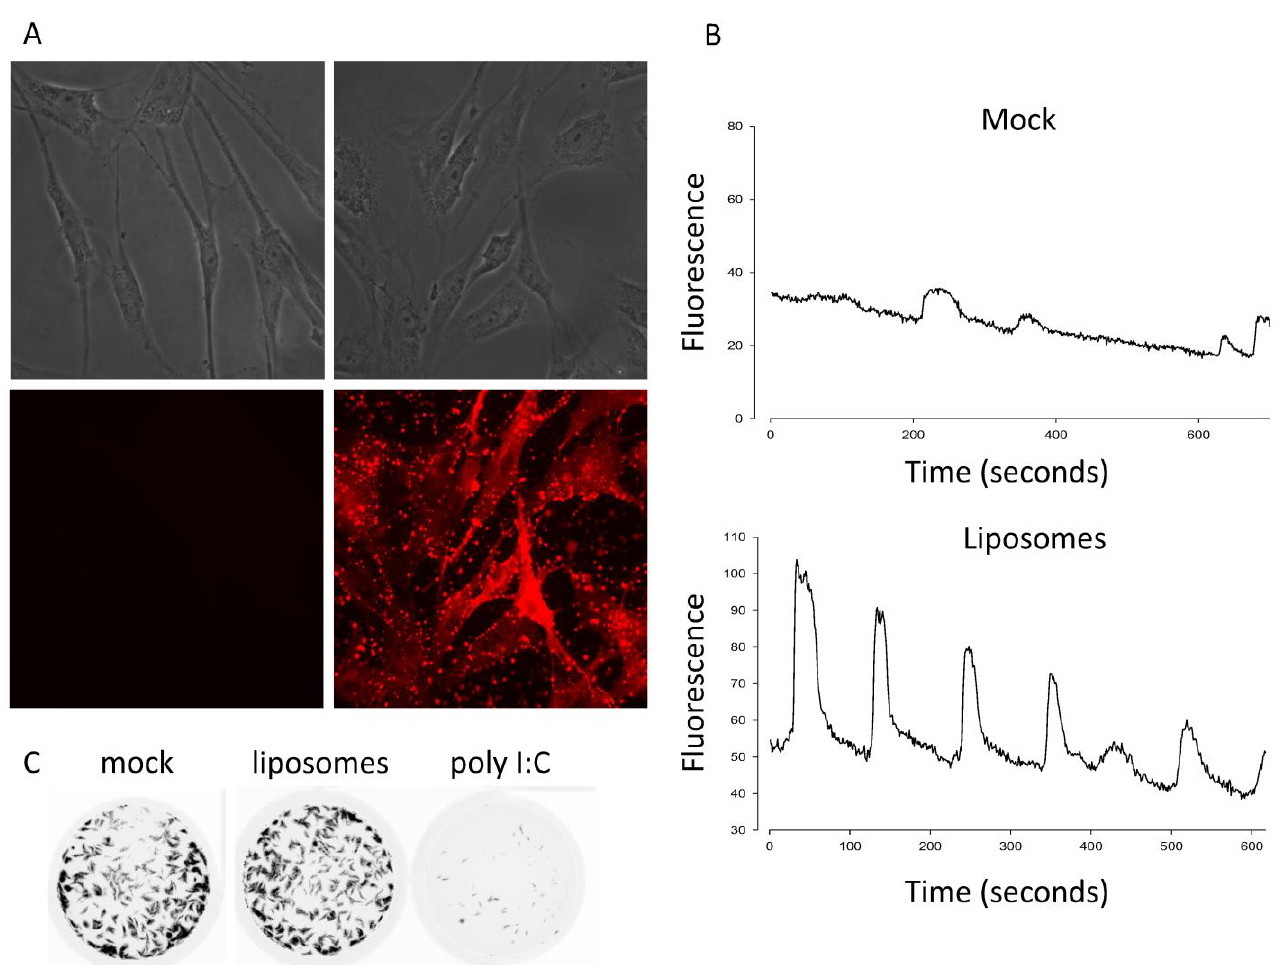
Figure 1. Ca2+ signaling is necessary but not sufficient to induce an antiviral state. ( A ) HEL fibroblasts were treated with fusogenic liposomes containing lissamine rhodamine-conjugated lipids or mock-treated and fixed 1 h later before imaging liposome incorporation by light (top) and fluorescence (bottom) microscopy. ( B ) HEL fibroblasts pre-loaded with a Ca 2+ -sensitive dye were treated with fusogenic liposomes, and the subsequent Ca 2+ oscillations were imaged by live-cell fluorescence microscopy. Fluorescence from 24 cells per treatment group over 3 biological replicates was plotted over a time period beginning 45 min after treatment, and representative plots are shown. ( C ) HEL fibroblasts were treated with poly I:C or fusogenic liposomes and challenged with VSV-GFP in a plaque reduction assay 16 h post treatment.